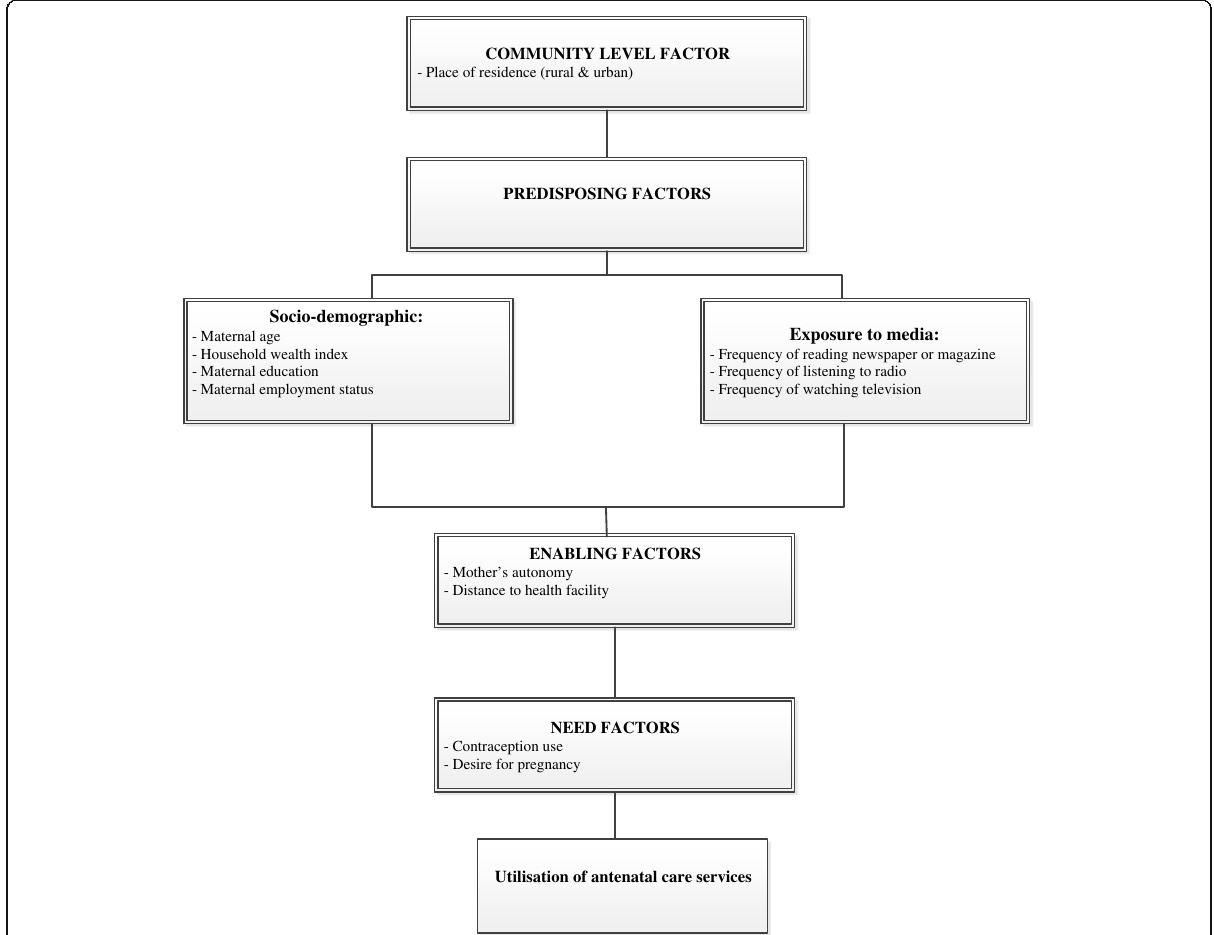
Fig. 1 The conceptual model for ANC service use in Tanzania adapted from Anderson ’ s health service utilization